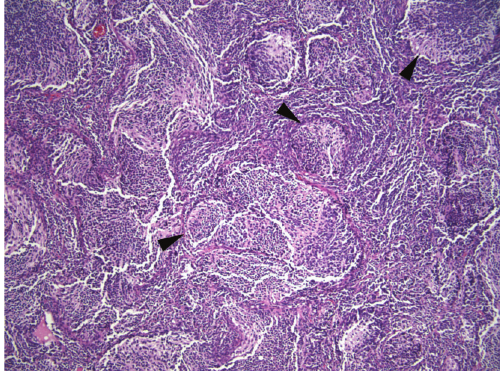
Figure 2: Histologic features of medulloblastoma with extensive nodularity. Hematoxilin and eosin section (4 µ m; 100x) reveals a malignant small blue cell tumor with widespread formation of nodules of uniform cells with neuropil formation surrounded by intervening areas of more densely populated pleomorphic cells consistent with a diagnosis of medulloblastoma with extensive nodularity. The arrowheads point to the nodular zones.